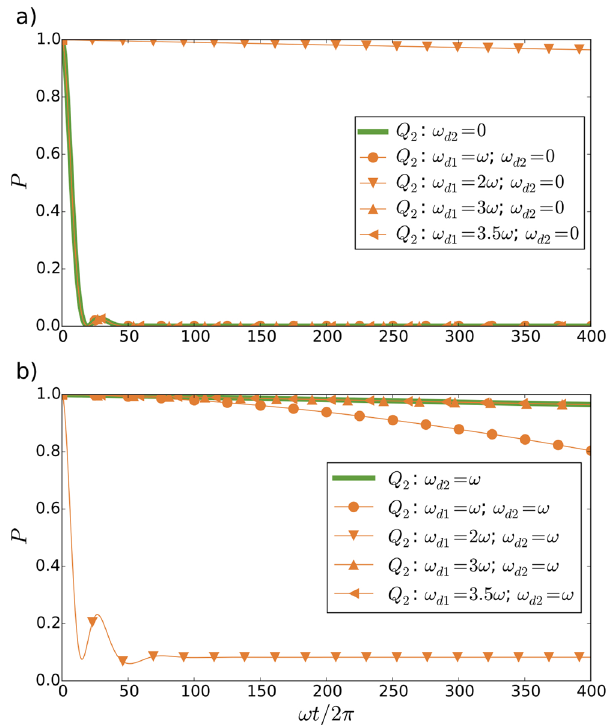
Figure 4. Motion effects in single-atom superradiance, observed in the probability P of excitation of the second qubit Q 2 . We consider the influence of the movement of the first qubit Q 1 by analysing different velocities ω d 1 and the decoupled case, g 1 = 0. The second qubit is moving with frequency ω d 2 , for an initial state g e 0 compute for a coupling constant g 1 = g 2 = 0.02 in the cases with the first qubit coupled, a qubit decay parameter Γ = 0.002 and T = 0.67, and a cavity decay rate κ = 0.2 (bad-cavity limit), in units of ω . We show the 2 / T 1 modification in the behaviour in the case of the second qubit ( a ) static ω d 2 = 0, and ( b ) moving with ω d 2 = ω